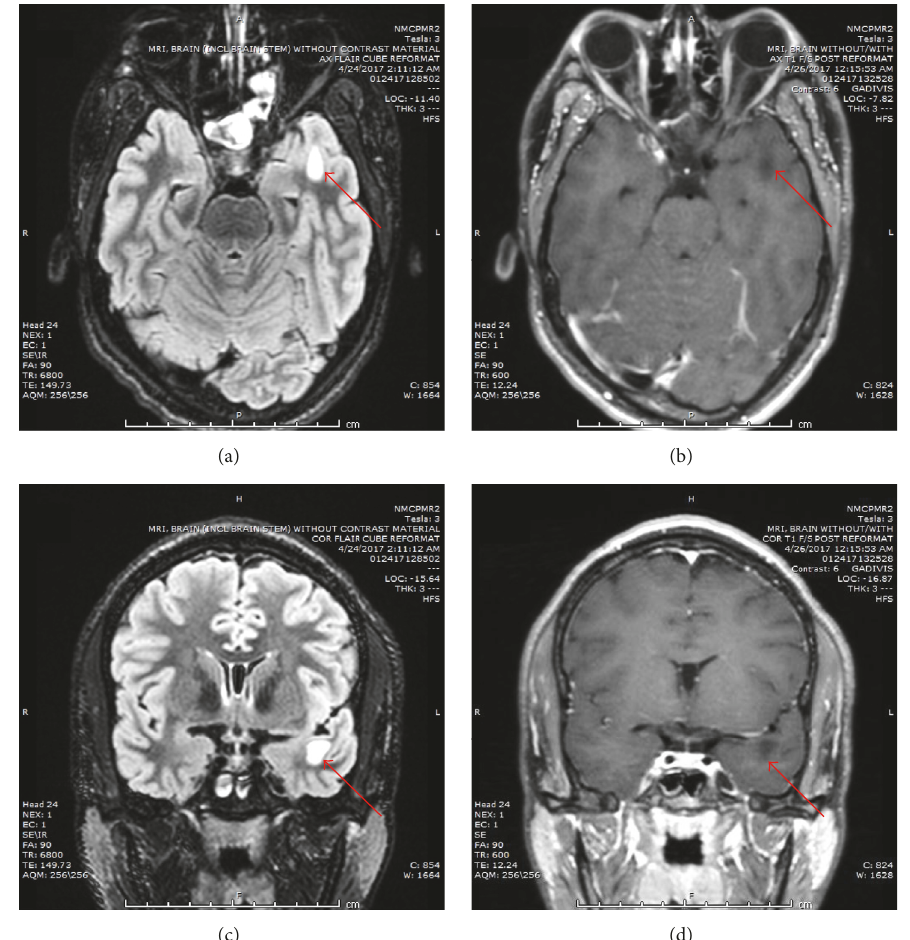
Figure1:BrainMRIdemonstratinglefttemporallobelesion.(a,c)AxialandcoronalT2weightedimages.(b,d)AxialandcoronalT1weighted images. Red arrow points to